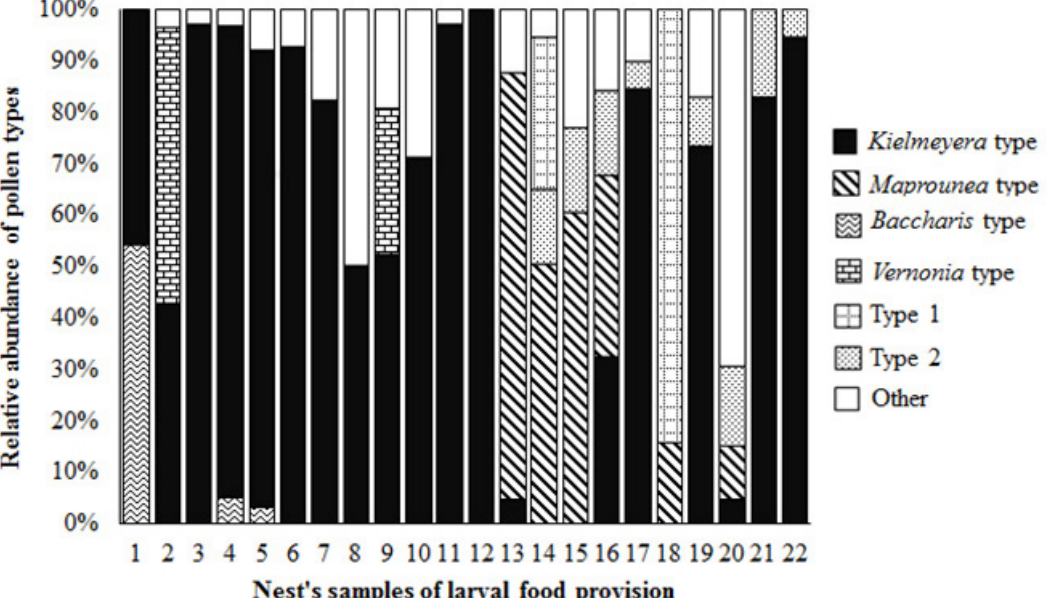
Fig 5. Relative abundance of the pollen types sampled in the larval food of Tetrapedia curvitarsis in cold/dry (samples 1 to 11) and hot/wet seasons (samples 12 to 22) in the period from April 2012 to March 2013, at the Água Limpa Experimental Station, Uberlândia-MG. *The category “Other” represents the other pollen types which presented relative abundance less than